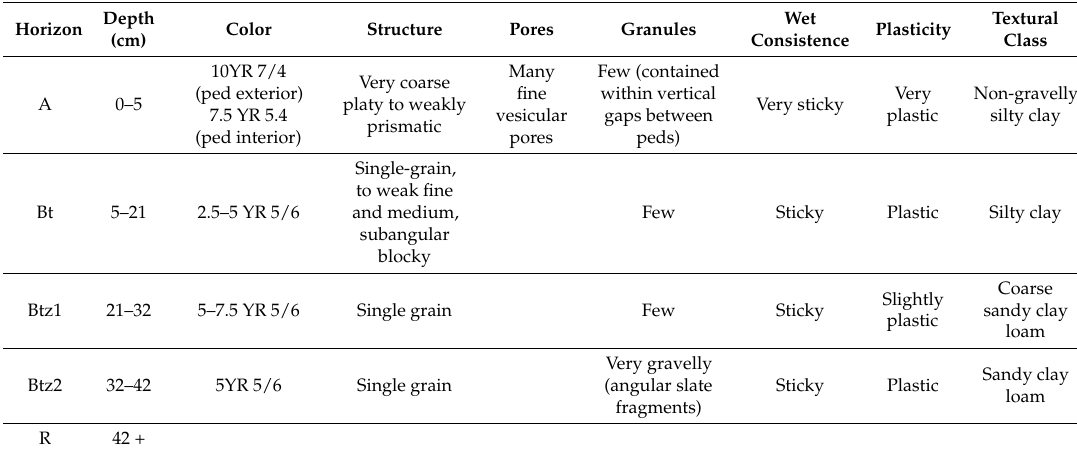
Table 2. Profile description of soil beneath a desert pavement in the Tankwa Karoo, Northern Cape Province, South Africa. (described by L.D. McFadden, 22 October